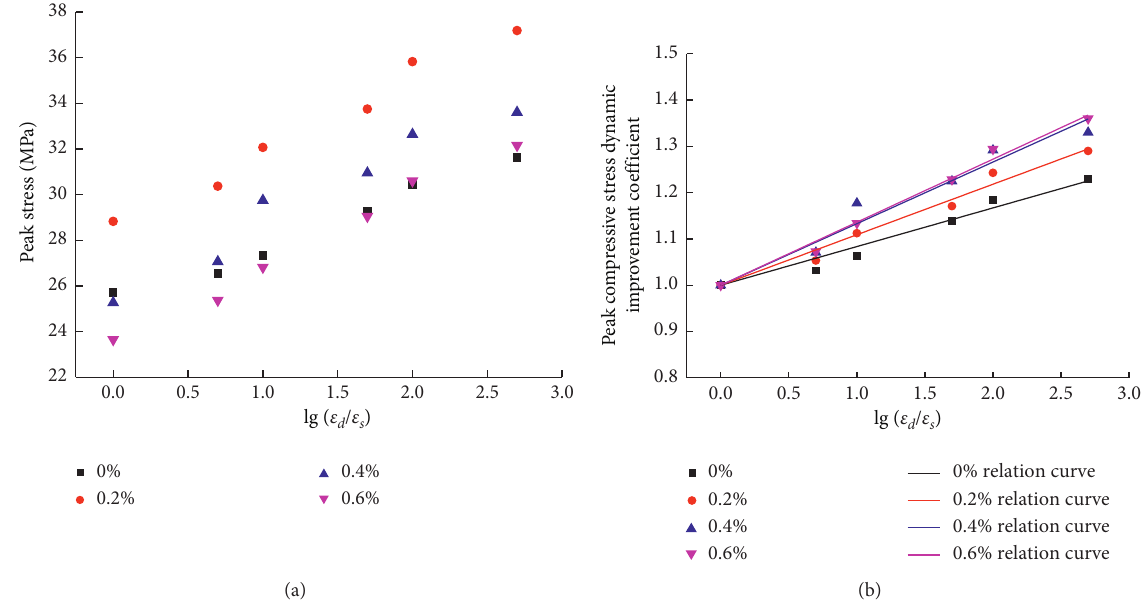
Figure 7: The compressive peak stress of polypropylene fiber reinforced concrete under different loading conditions. (a) Peak compressive stress. (b) Peak compressive stress dynamic improvement coefficient.